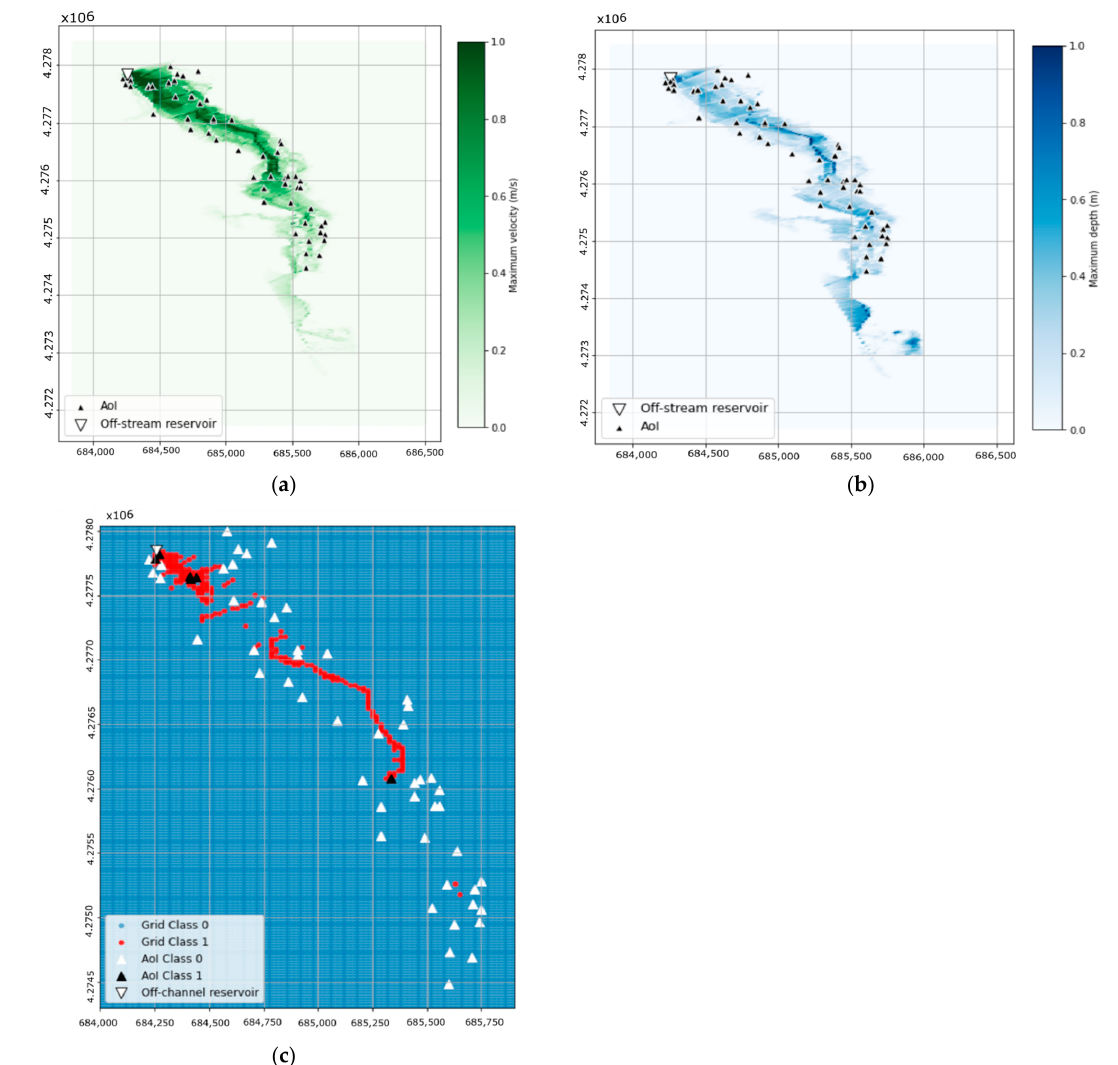
Figure 15. Results from the complete method (Iber). ( a ) Maximum velocity; ( b ) maximum depth; ( c ) Map of potential hazard based on the results from Iber. Axes represent UTM coordinates.